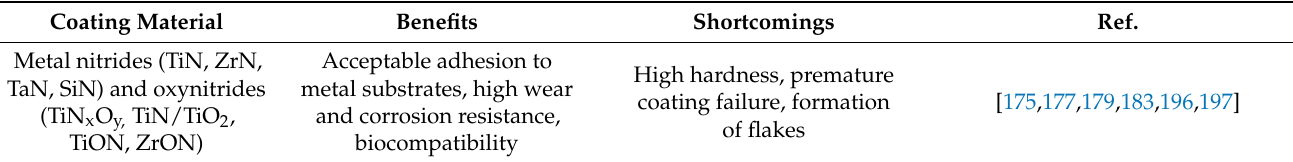
Table 3. Pros and cons of various bioactive coatings applied for hard tissue applications. Coating Material